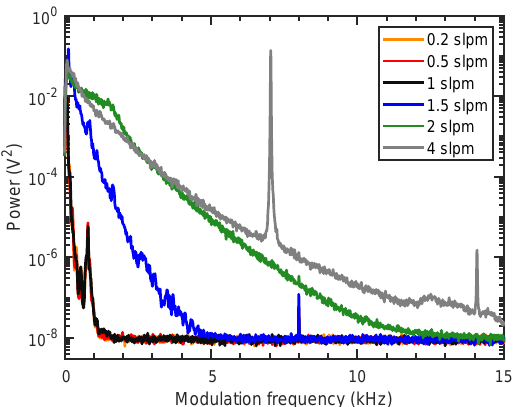
Figure 4. Welch spectra of the background noise without excitation laser at different flow rates. Welch spectra are calculated over 0.1s windows and averaged over 9s. The noise spectra of 0.2slpm and 0.5slpm are identical and covered by the spectrum at